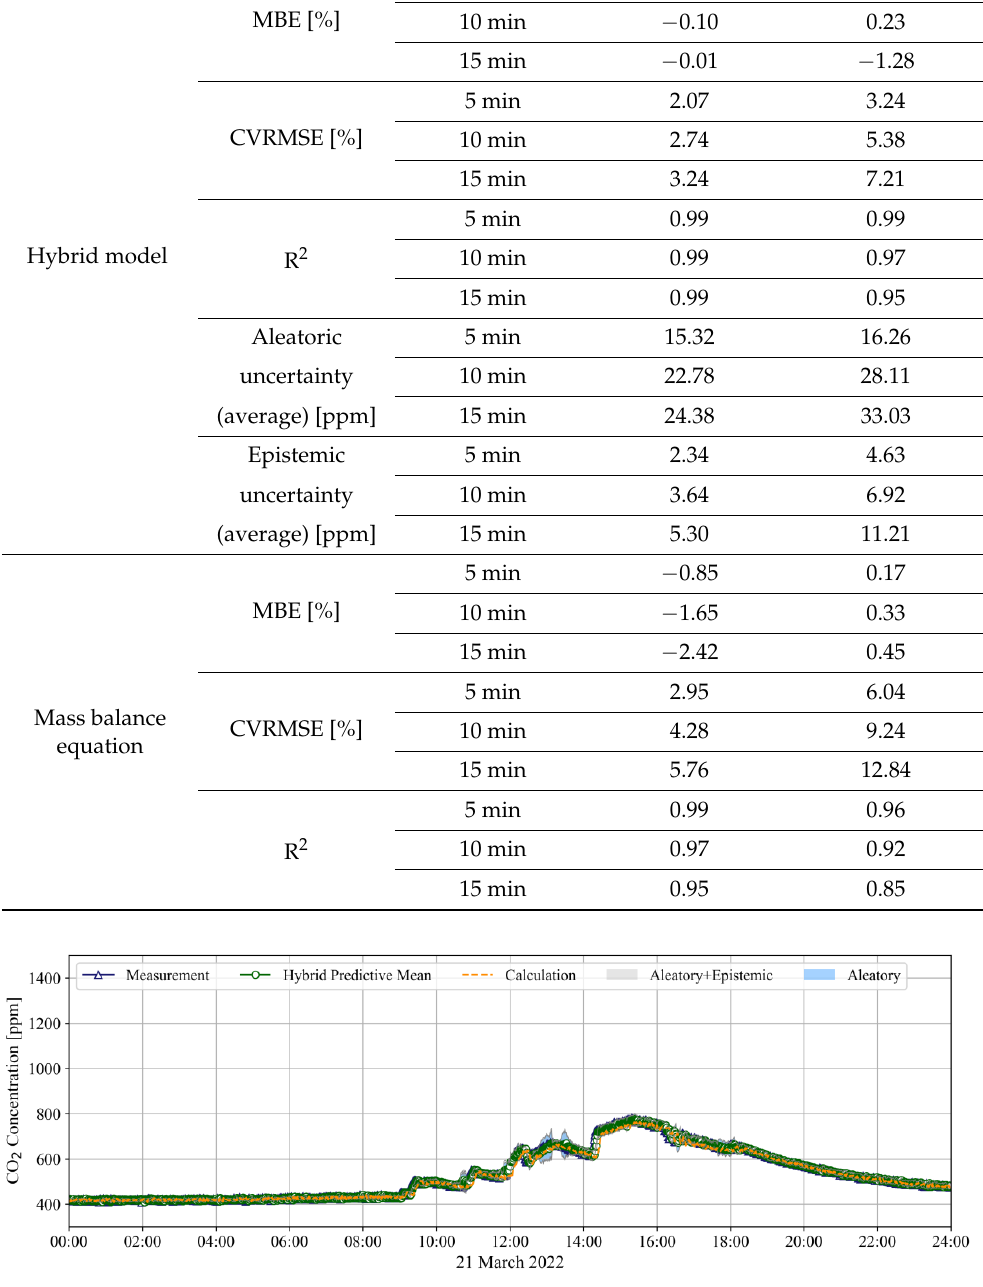
Table 3. Forecasting accuracy and uncertainty